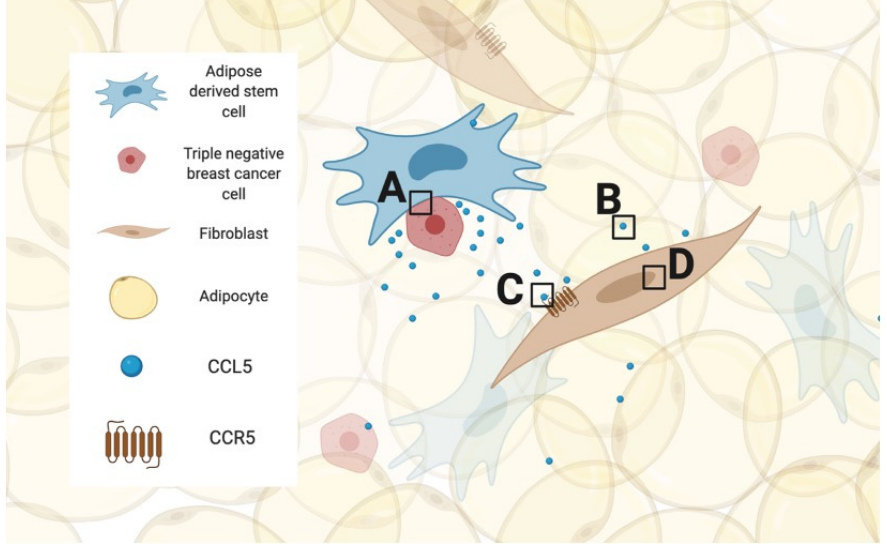
Figure 2. Schematic of options to pharmaceutically manipulate in the CCL5/CCR5 signaling pathway. Figure legend on left. Boxes A–D highlight areas in the cell relationship which represent targetable stages.